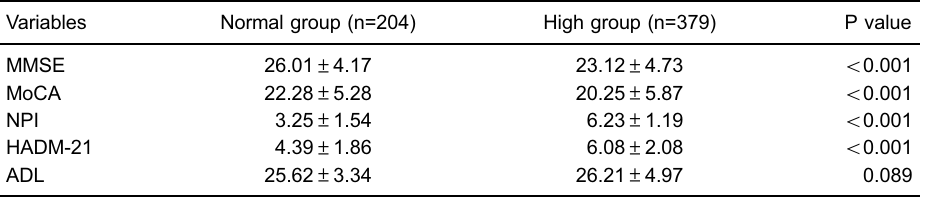
Table 3. Comparison of neuropsychological scale scores of patients between the normal and high non- high-density lipoprotein cholesterol groups.